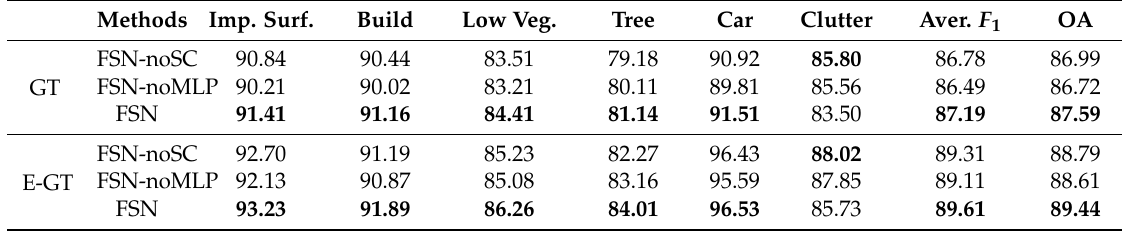
Table 5. Experimental results on the effect of sub-pixel convolution and multi-layer perceptron (Potsdam validation set). FSN-noSC is FSN without sub-pixel convolution version; FSN-noMLP is FSN without multi-layer perceptron version.